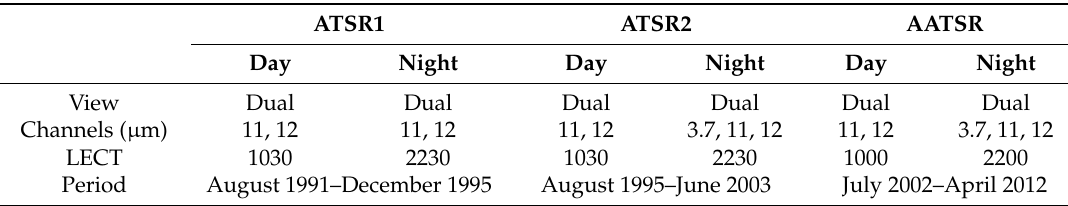
Table 2. Primary channels, satellite views and local equator crossing time for the different ATSR sensors and daytime/night time retrievals. ATSR1 ATSR2 AATSR Day Night